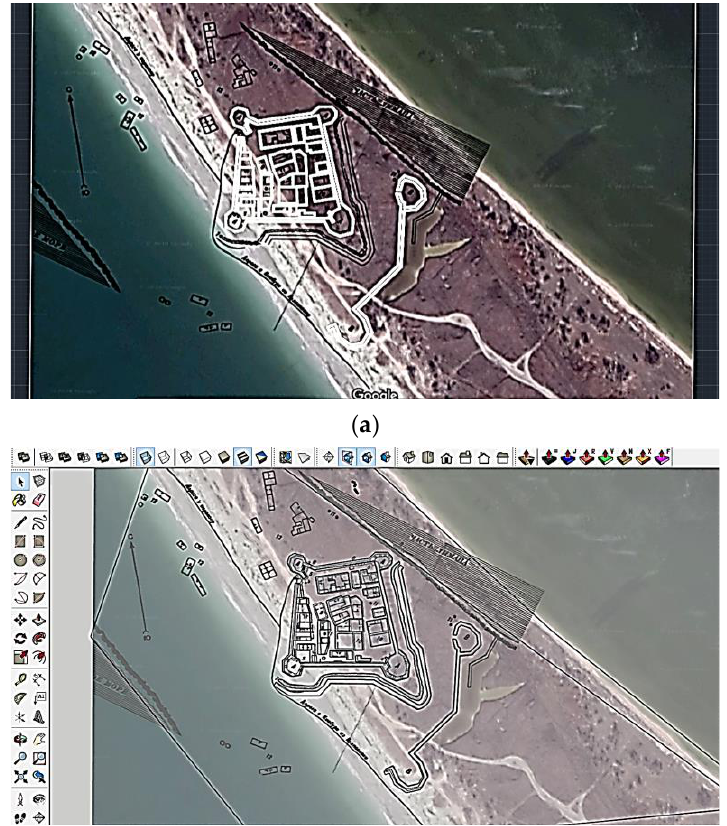
Figure 5. Scaling ( a ) and processing ( b ) of the summary map.